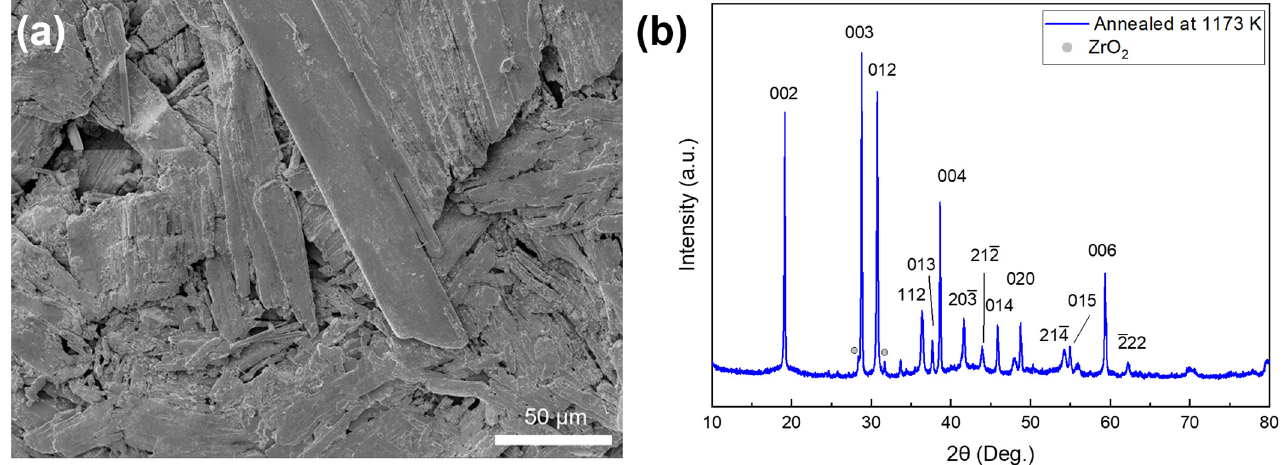
Figure 4. ( a ) SEM image of the ZrSe 3 sample after cold-pressing showing the fracture surface perpendicular to the press direction. ( b ) Powder XRD pattern of ZrSe 3 after annealing at 1173 K in vacuum.